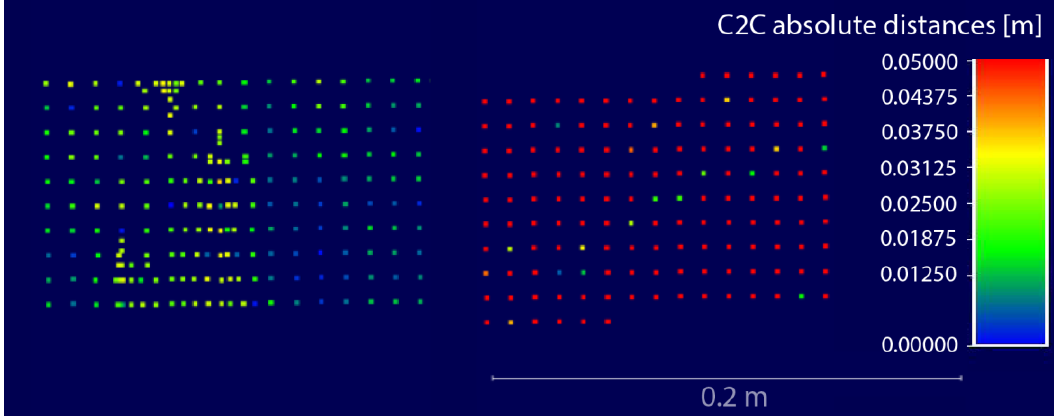
Figure 4. A detail of C2C distances of a featureless floor area in the hall 101 Matterport point cloud ( left ) and Theta V point cloud ( right ).